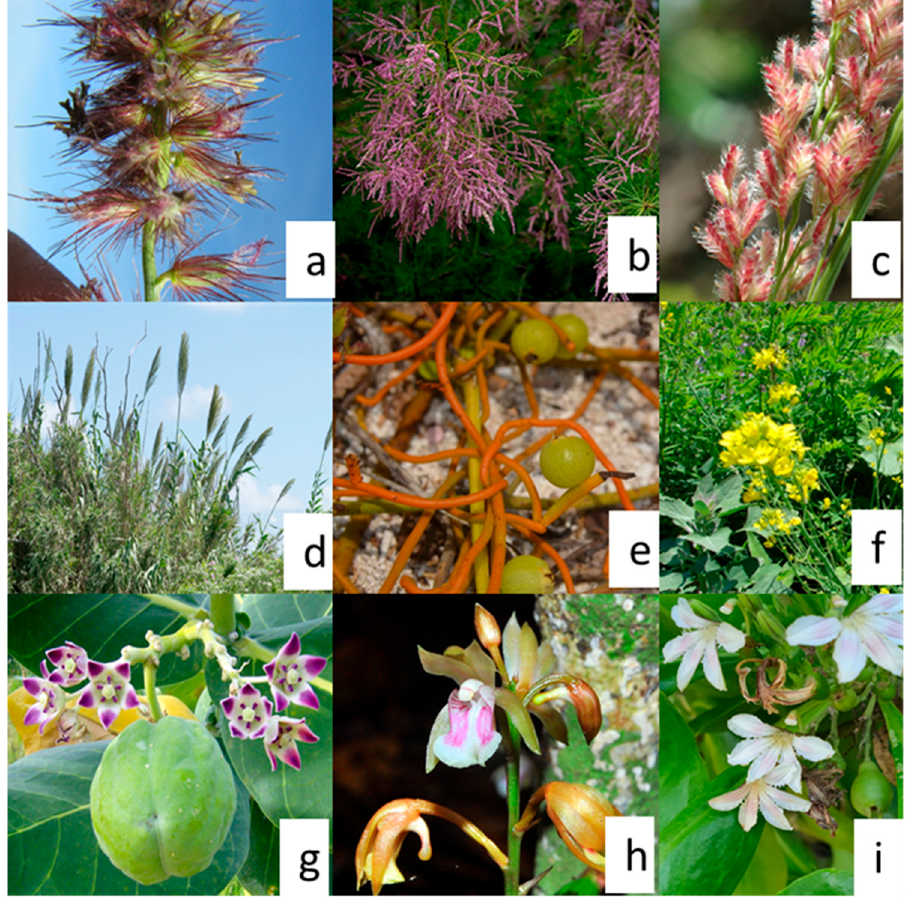
Figure 3. Invasive species found on Mexican coastal dunes. ( a ) Cenchrus ciliaris (Flickr); ( b ) Tamarix ramosissima ((PxFuel); ( c ) Eragrostis ciliaris (Naturalista); ( d ) Arundo donax (Naturalista); ( e ) Cassytha filiformis (Donaji Graham, Naturalista); ( f ) Hirschfeldia incana (Flickr); ( g ) Calotropis procera (Natural- ista); ( h ) Oeceoclades maculata (Flickr) ( i ) Scaevola taccada (M. Luisa Mart í nez). Picture credits are in parenthesis after the name of each